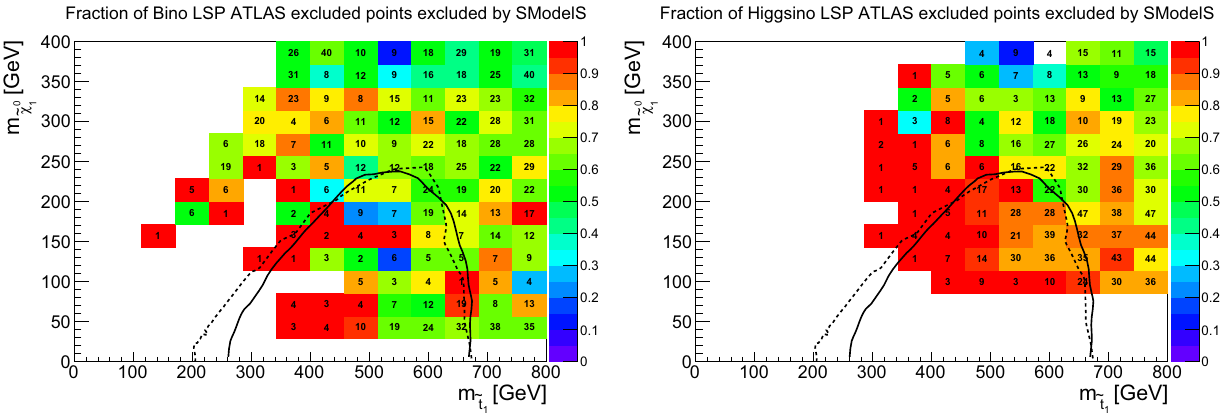
Fig. 8 Coverage in the stop vs. neutralino mass plane, for ˜ t 1 masses up to 800 GeV, for bino-like LSP scenarios (left) and higgsino-like LSP scenarios (right). The color code indicates the fraction of points excluded by SModelS as compared to ATLAS, while the text gives